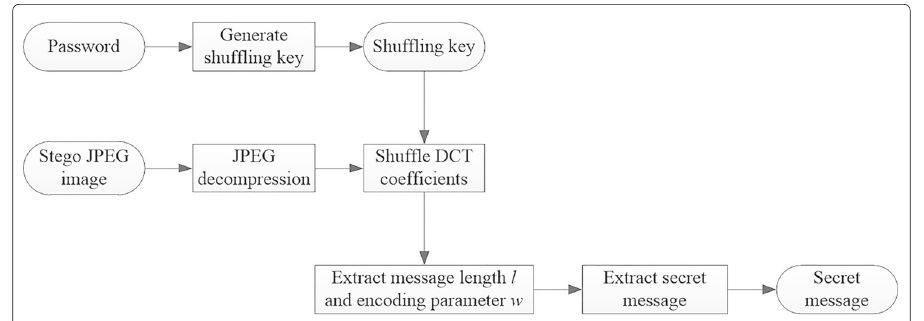
Fig. 2 Extraction procedure of F5